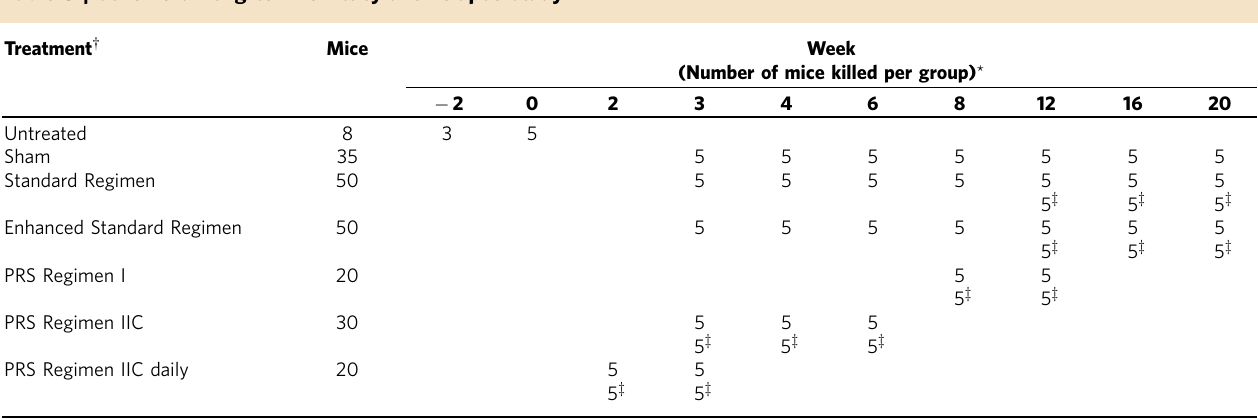
Table 3 | Scheme of long-term efficacy and relapse study. Treatment w